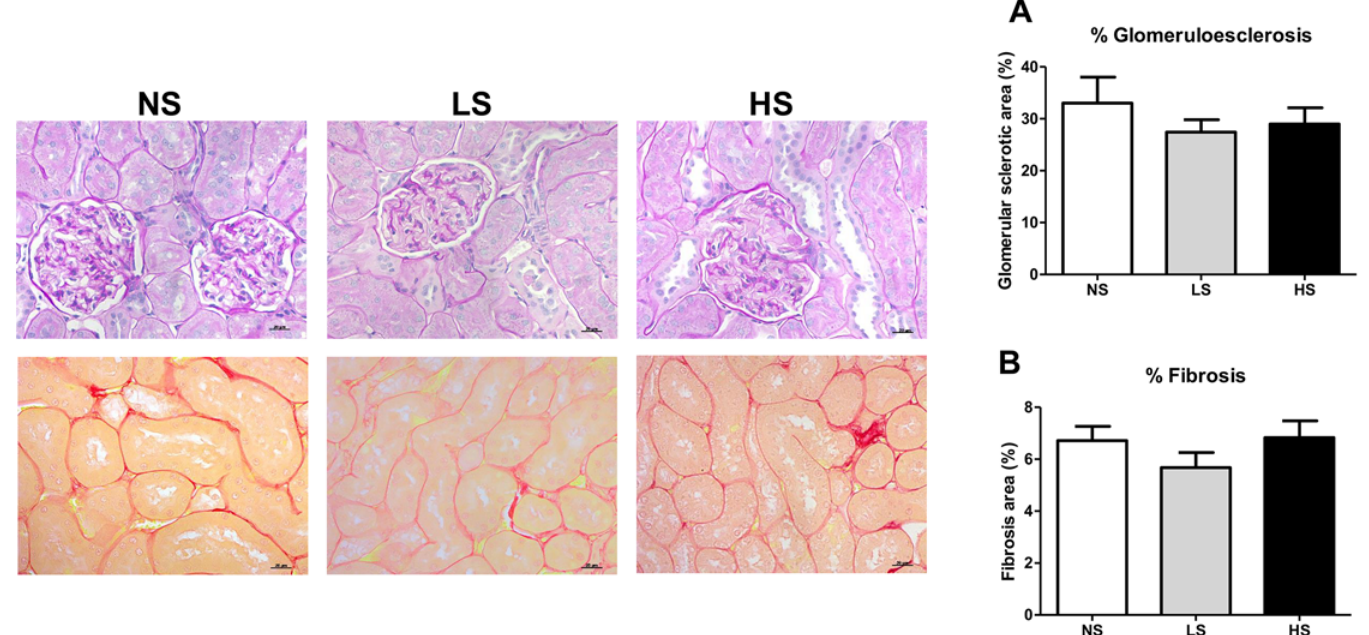
Fig 6. Histological analysis. (A) Photomicrographs of kidney sections stained with Periodic Acid Schiff (PAS) to determine glomerulosclerosis score (percentage of the PAS-positive in glomerular tuft area) and morphometric changes in the groups. (B) Photomicrographs of kidney sections stained with Picrosirius Red to determine interstitial collagen deposition. Data are represented as mean ± SEM. NS: normal salt diet. LS: low salt diet. HS: high salt diet. Scale bar: 20 μ m.